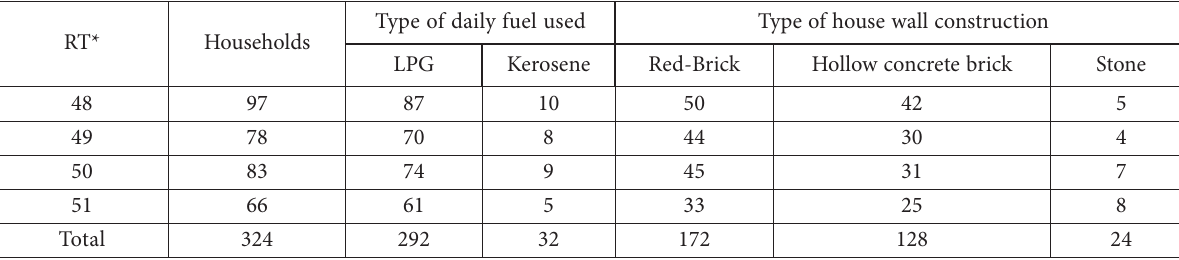
Table 4. Total amount of households used daily fuel and type of house wall per